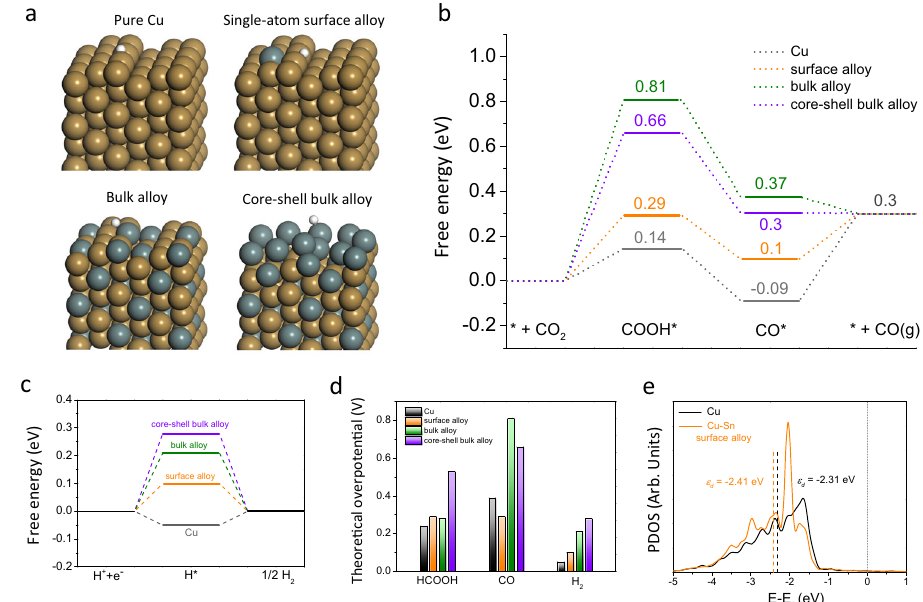
Fig. 5 DFT simulations of CO 2 RR on Cu – Sn atomic interfaces. a The theoretical model structures on stepped facets of pure Cu, Cu – Sn surface alloy, bulk alloy and core-shell bulk alloy with adsorbed H*. The dark goldenrod and slate gray balls represent Cu and Sn atoms, respectively. The structures of the intermediates are shown in Supplementary Fig. 15. b The calculated free energy diagrams of CO 2 -to-CO conversion. c The calculated free energy diagrams of HER. d The theoretical overpotentials of HCOOH, CO, and H 2 production on catalysts. e The projected density of states (PDOS) of d orbitals of active Cu atoms at the step edges on pure Cu and Cu – Sn surface alloy. The dotted gray line indicates the Fermi level. The d -band centers ( ɛ d ) are denoted by dashed